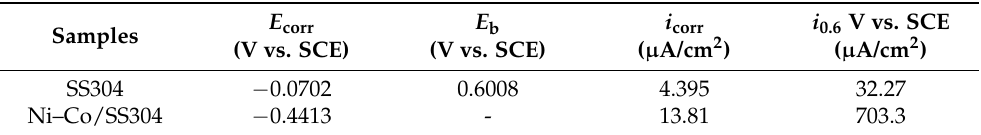
Table 2. Polarization parameters derived from potentiodynamic polarization curves of SS304 and Ni–Co/SS304 shown in Figure 7a.